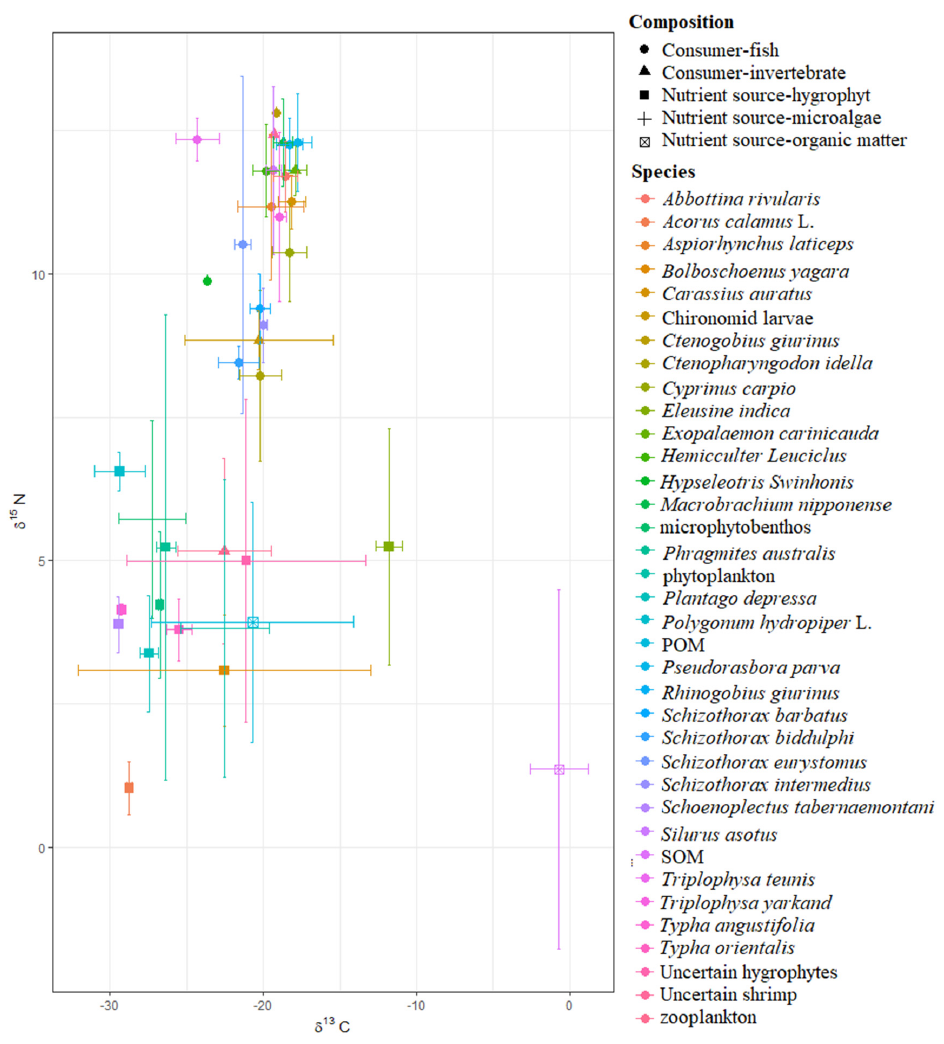
Figure 2. Overall trophic position based on mean stable isotope values (error bars indicate standard deviation) for organisms from the Kizil reservoir. (POM: particulate organic matter, SOM: soil organic matter). Table 2. Stable isotope metrics for 13 fish species in the Kizil Reservoir a